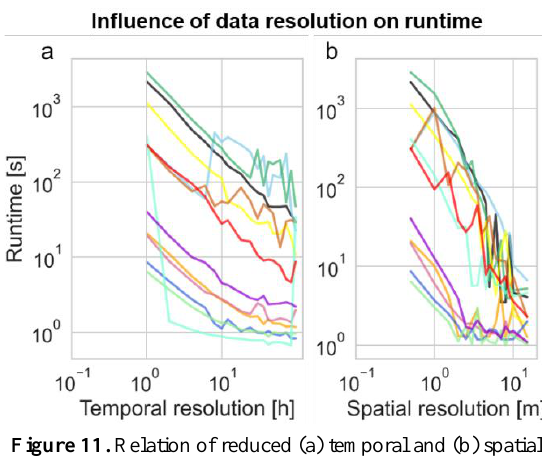
Figure 11. Relation of reduced (a) temporal and (b) spatial resolution to runtime for spatial delineation of individual 4D objects-by-change (each designated by distinct colour). Runtime values are runtimes of region growing on a standard desktop